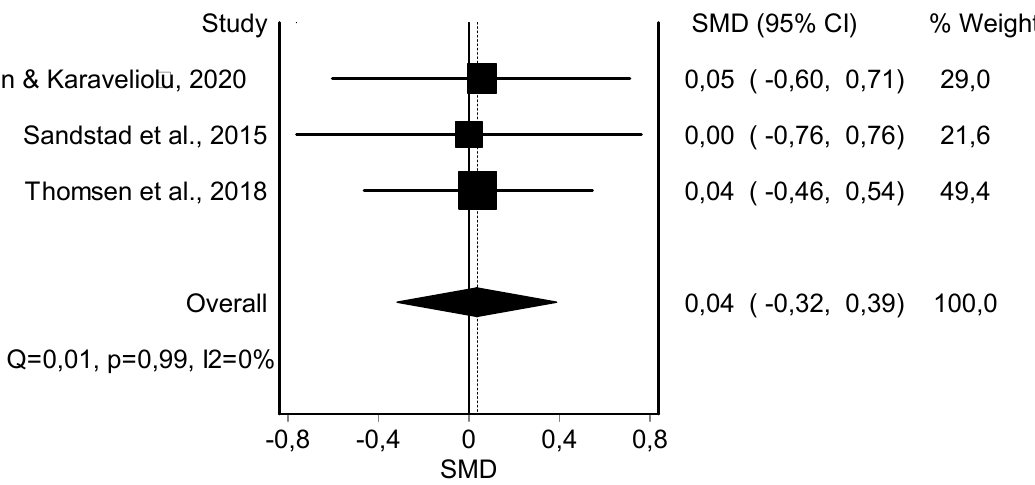
Figure A10. Synthesis forest plot of muscle mass variable. Positive favor HIIT intervention. The forest plot summarizes the results of included studies (standardized mean differences [SMDs] and weight). The small boxes with the squares represent the point estimate of the effect size and sample size. The lines on either side of the box represent a 95% confidence interval (CI).